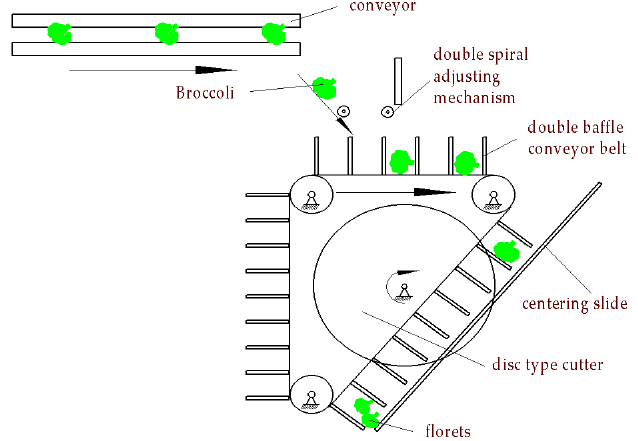
Figure 10. Schematic diagram of the broccoli secondary cutting process and equipment.